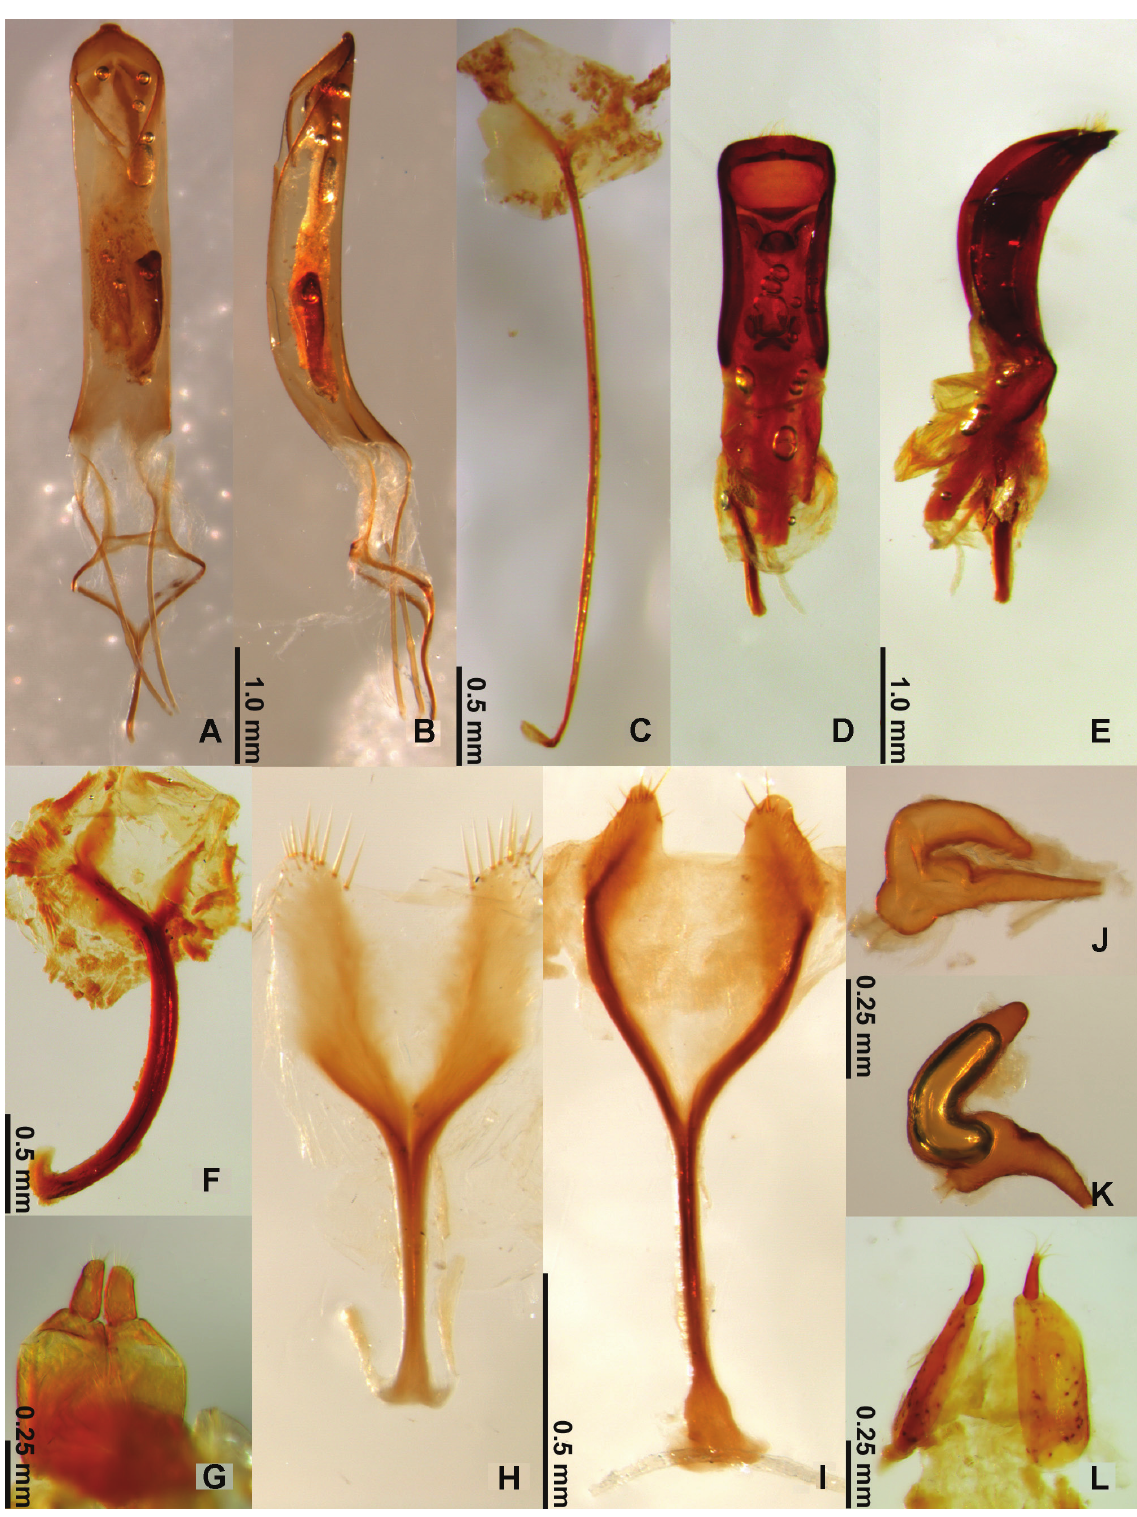
Fig. 2. A-C . Heilipodus goeldii sp. nov., holotype. A . Aedeagus dorsal. B . Ditto ventral. C . Ventrite 8. — D-F . Heilipodus polyspilus (Pascoe, 1889), ditto. — G-H, J . Heilipodus huguenini (Reitter, 1891) comb. nov., holotype. G . Ovipositor. H . Ventrite 8 of female. J . Spermatheca. — I, K-L . Heilipodus goeldii sp. nov., paratype. I . Ventrite of female 8. K . Spermatheca. L .